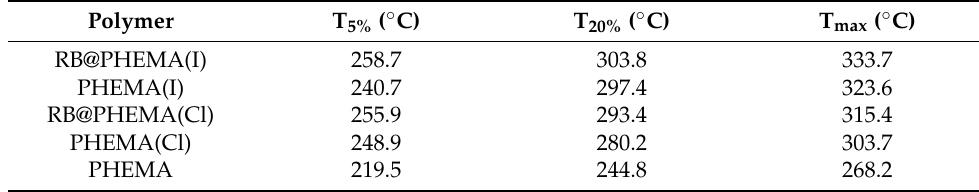
Table 2. TGA Data of PHEMA